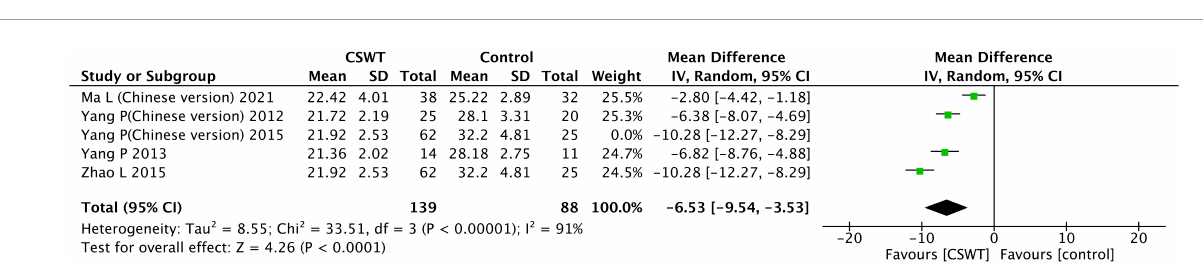
FIGURE13 Forest plot of the CSWT group vs. the control group-total score of metabolism imaging.